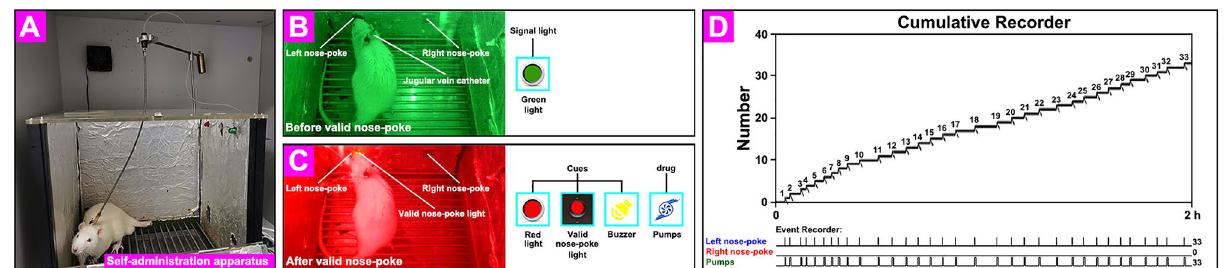
Figure 4. Self-administration training for rats. ( A ) Self-administration apparatus. ( B , C ) The comparison before and after valid nose-poke for experimental rat. Before valid nose-poke, only green light is on (B). When the experimental rats finish a valid nose-poke, the system pumps the drug once (T = 1.25 s, ν = 1.60 mL/min), which accompanies a series of changes in environmental cues such as signal lights (a green light turning off and a red light turning on for 20 s), a valid nose-poke light (T = 20 s), and a sound (buzzer, T = 1.25 s) ( C ). ( D ) The original recording of experimental rat’s behavioral